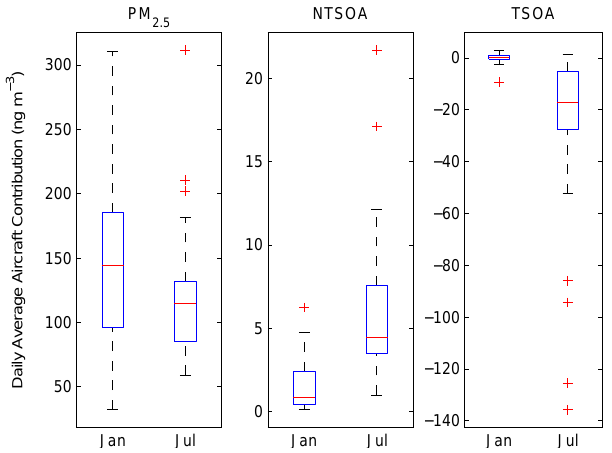
Figure 2. Speciated monthly average PM 2 . 5 contributions from aircraft in the grid cell containing the Atlanta airport in Jan- uary and July. Species include non-traditional SOA from engine idle activities (NTSOA-I), non-traditional SOA from all other en- gine modes (NTSOA), sulfate (ASO4), primary organics (POA), biogenic TSOA (AORGB), anthropogenic TSOA (AORGA), am- monium (ANH4), nitrate (ANO3), and elemental carbon (AEC) aerosols.